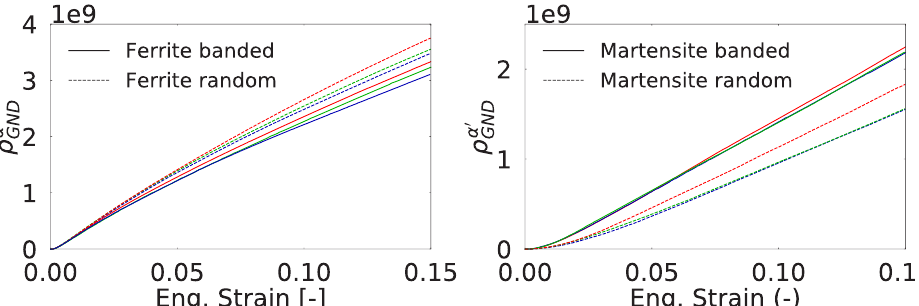
Figure 10. Evolution of GND density in the RVEs for ferrite ( left ) and martensite ( right ). Each color represents an orientation set.